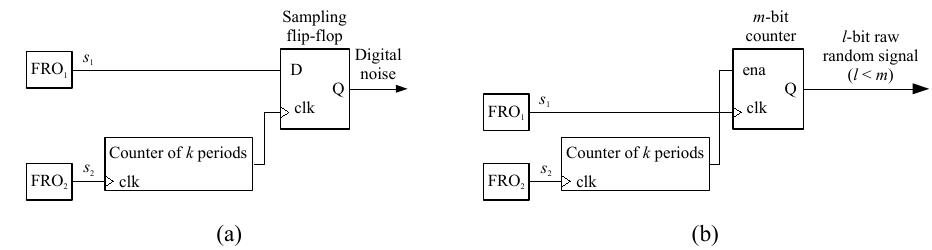
Figure 2: Generation of random numbers from the jittery clock signals s 1 and s 2 using a sampler (a) and a counter (b). Signals s 1 and s 2 are generated in two free running oscillators (FRO) of the same type and